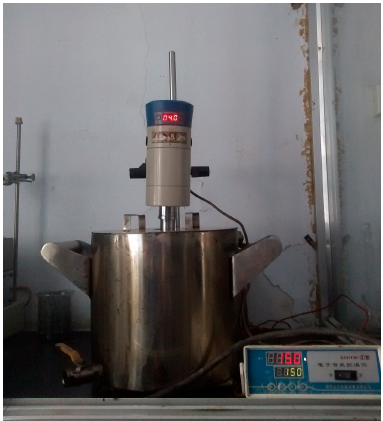
Figure 2. Mixing process of asphalt modification.